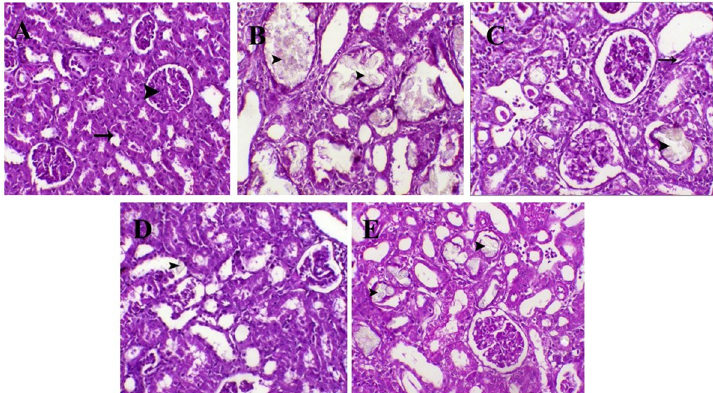
Fig 4. Photomicrograph of kidney tissue sections stained with H&E (X200): (A) NC group normal renal glomeruli (arrow head) and tubules (arrow); (B) EG group severe tubular degeneration with massive tubular urolithiasis (arrowheads); (C) CYS group moderate degeneration (arrow) and tubular urolithiasis (arrowhead); (D) STS group mild degeneration and tubular urolithiasis (arrowhead); (e) CAND group moderate degeneration and tubular urolithiasis (arrowheads). NC: Normal control; EG: Ethylene glycol; CYS: Cystone; STS: Sodium thiosulfate; CAND: Candesartan.